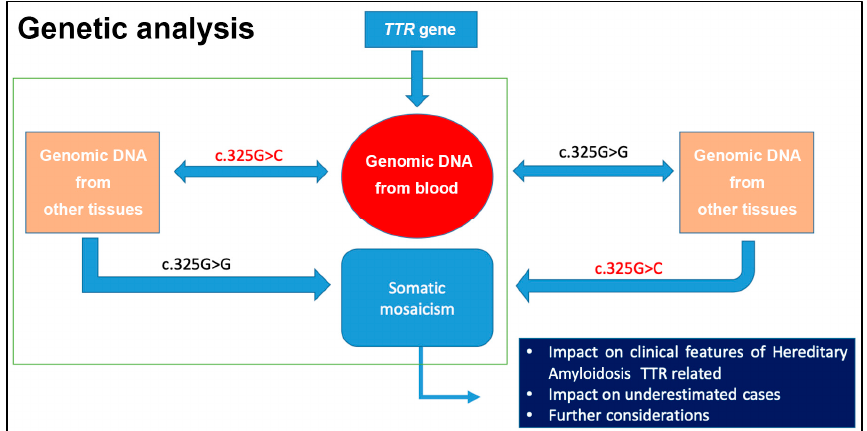
Figure 4. Relevance to analyze genomic DNA from several tissues, as in the case of G>C mutation in the TTR gene (NM_000371.3:c.325G>C) [14]. the TTR gene (NM_000371.3:c.325G>C)